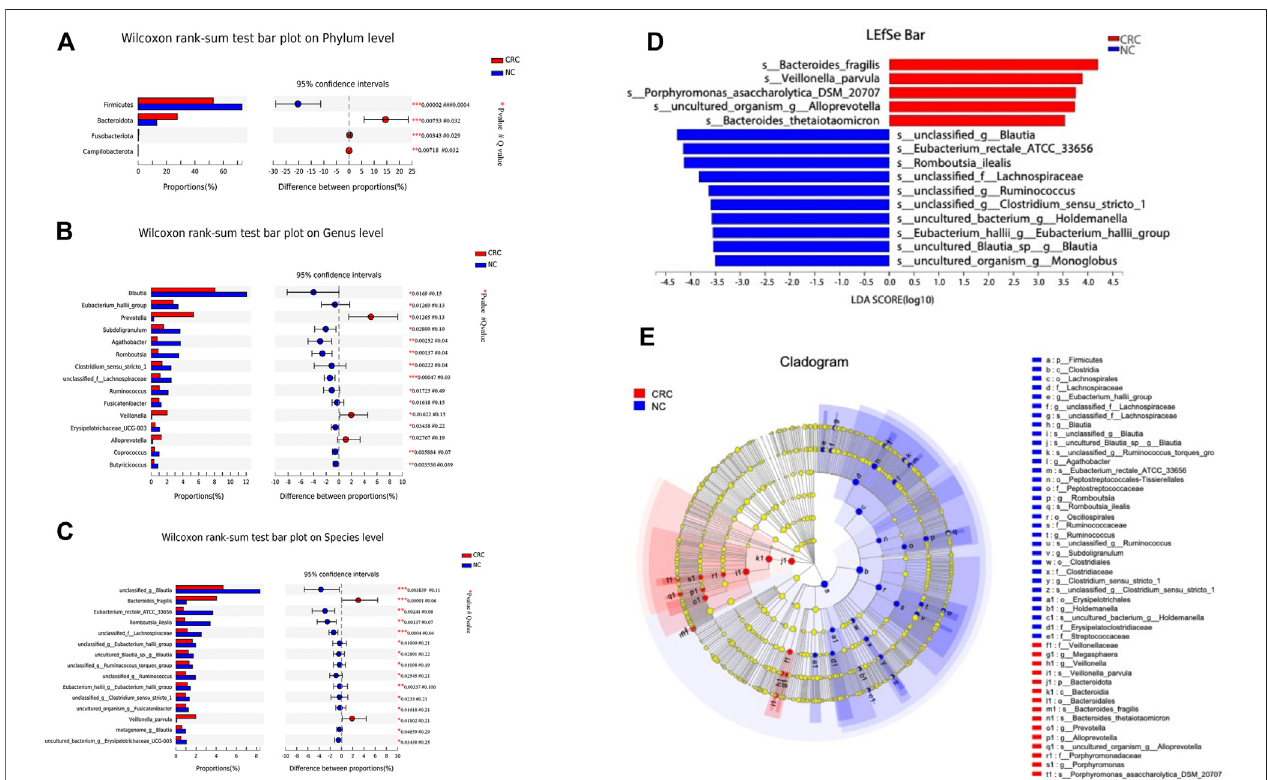
FIGURE 2| Comparison ofthe abundance of fecalmicrobiota by CRC and NC groups. (A-C) Relative abundance of the bacterial composition in the CRC and NC groups at the phylum, genus, and species levels. (D) LEfSe analysis of enriched bacterial taxa in the gut microbiota of the CRC and NC groups (LDA > 3.5 of LEfSe). (E) Cladogram representation of the taxonomic differences between the CRC and NC